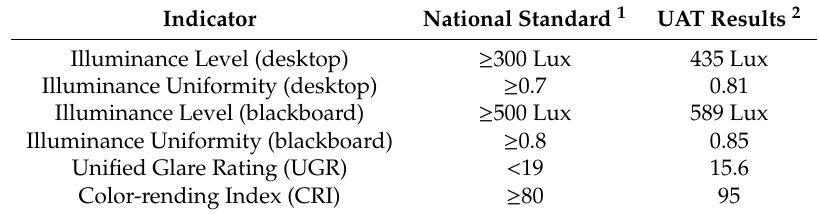
Table 13. The checked illuminance indicators during the project user acceptance testing (UAT).